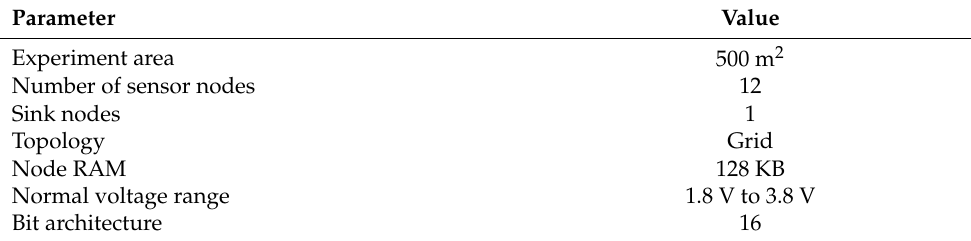
Table 6. Experiment